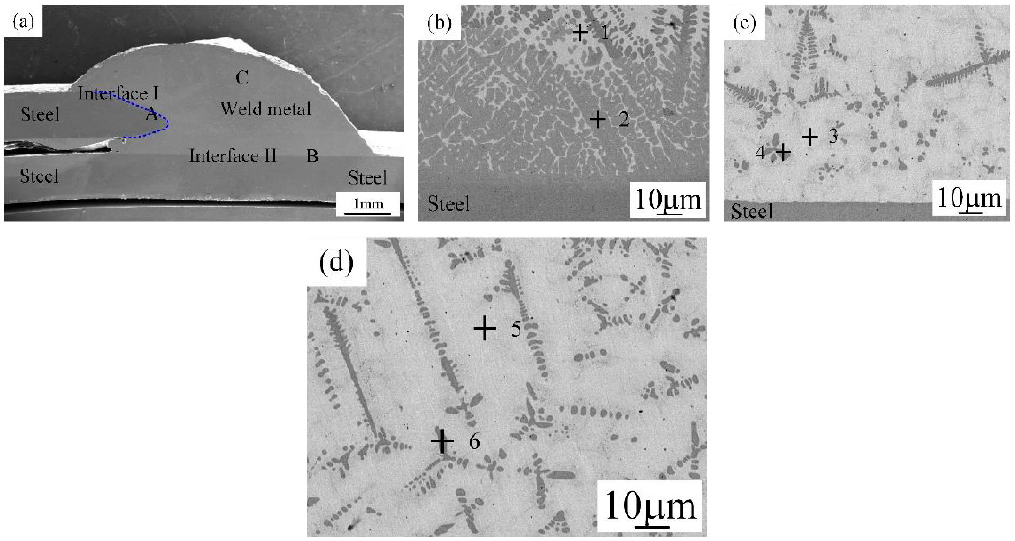
Figure 7. The microstructure of Joint III (sample #3); ( a ) the cross-section sample, ( b ) magnified zone A in Figure 7a, ( c ) magnified zone B in Figure 7a and ( d ) magnified zone C in Figure 7a. Table 6. EDS analysis results of various zones for Joint III (specimen #3) in Figure 7 (at. %). Point.